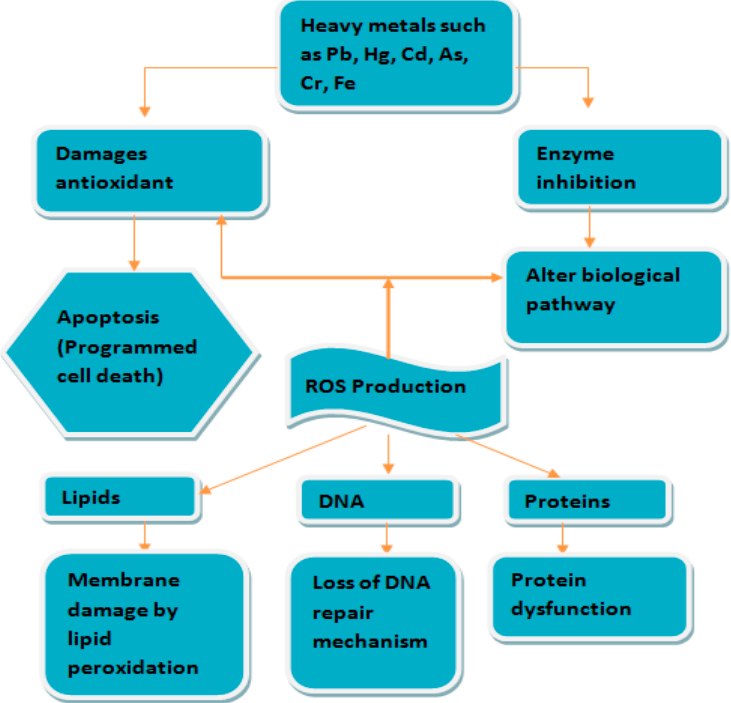
Figure 3. Attack of heavy metals on a cell resulting in the production of reactive oxygen species (ROS).